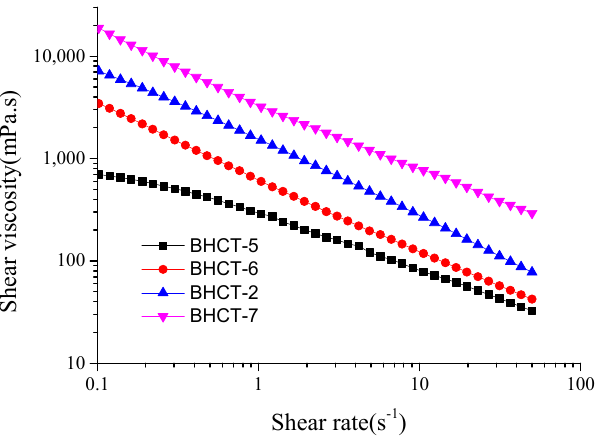
Figure 6. Viscosity curve of composite gels at different bentonite concentrations.